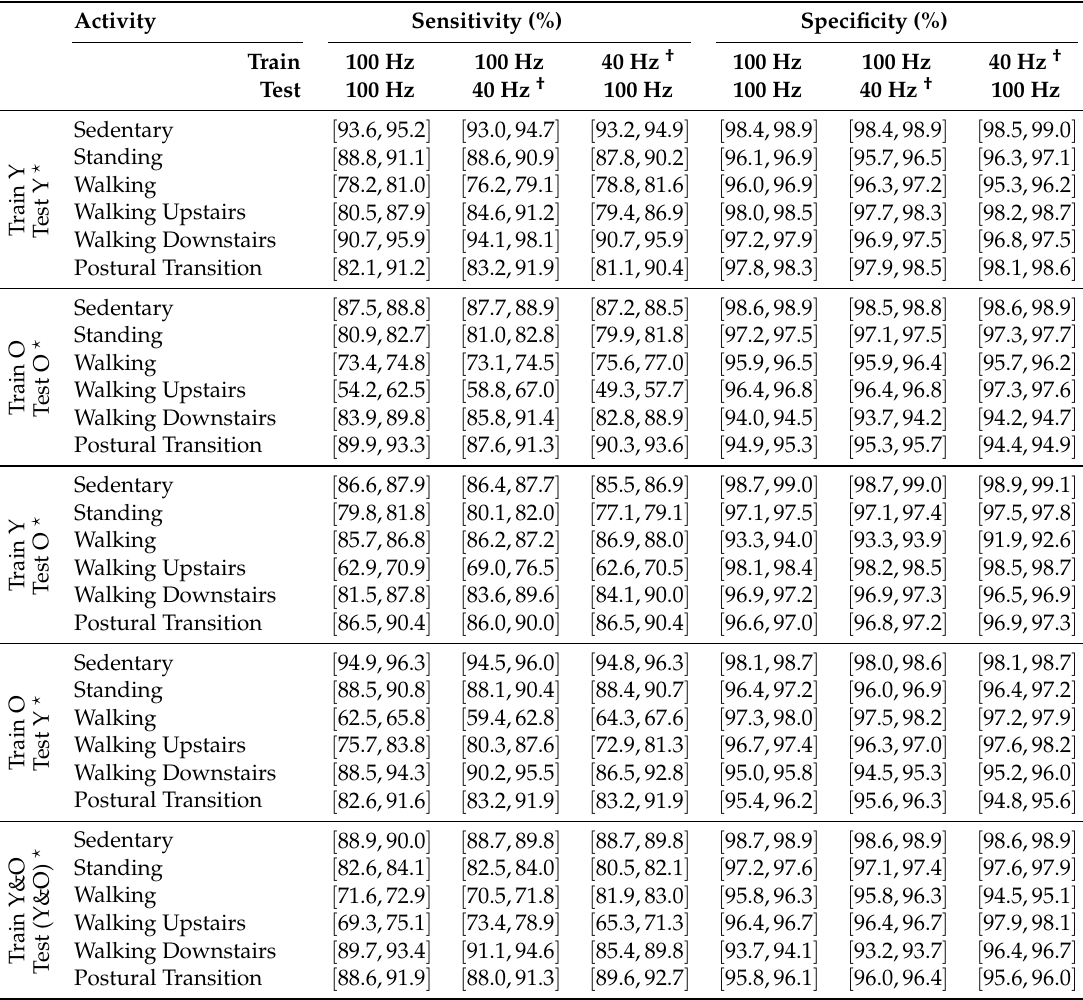
Table A2. Ninety-five percent confidence intervals for the sensitivity and specificity of each activity when hierarchical models for human activity recognition were developed with the best